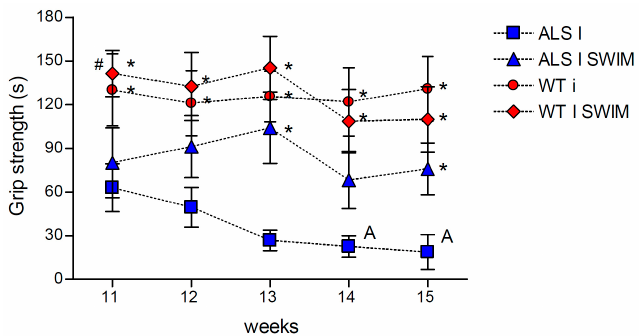
Figure 1. The effects of swim training on grip strength in the ALS mice. Swim training maintained grip strength in ALS mice. There were significant differences between the groups: * p < 0.05 vs. symptomatic ALS mice (ALS I), # p < 0.05 vs. ALS I SWIM; A p < 0.05, between the indicated time points and 11 week in ALS I group (LSD post hoc test). The data are presented as the means ± SEM ( n = 8 in each group). ( n = 8 for each group).